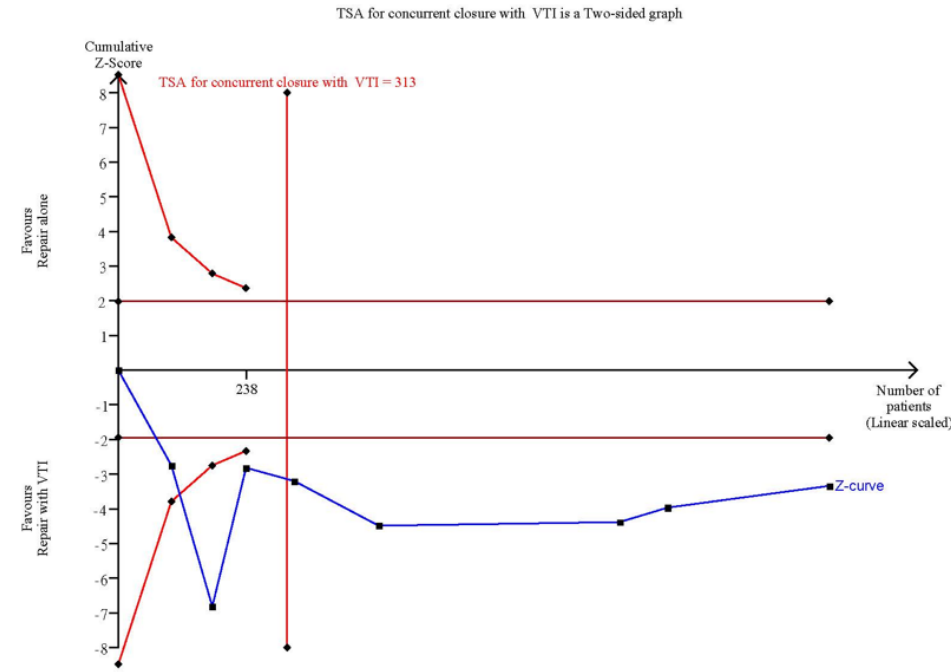
Figure 7. TSA of effect of concurrent VTI with palatal repair.